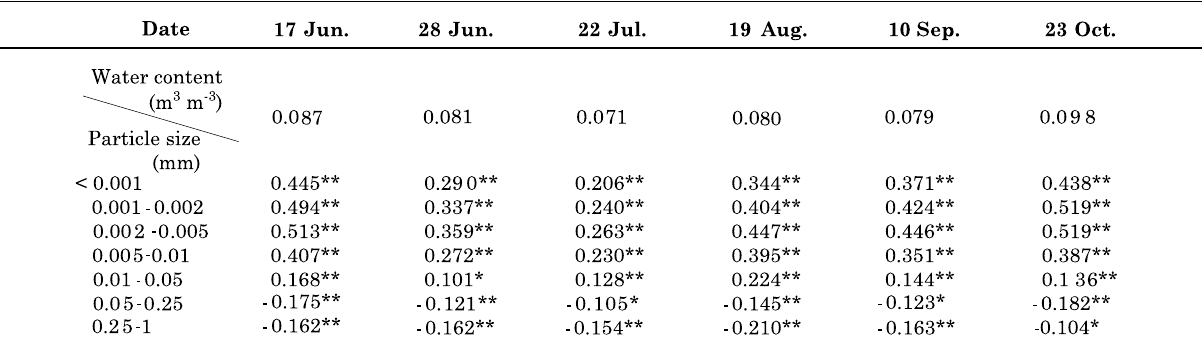
Table 3. Pearson correlation coefficients between the particles and soil water content in the filled deposited farmland soils of random days as a sample